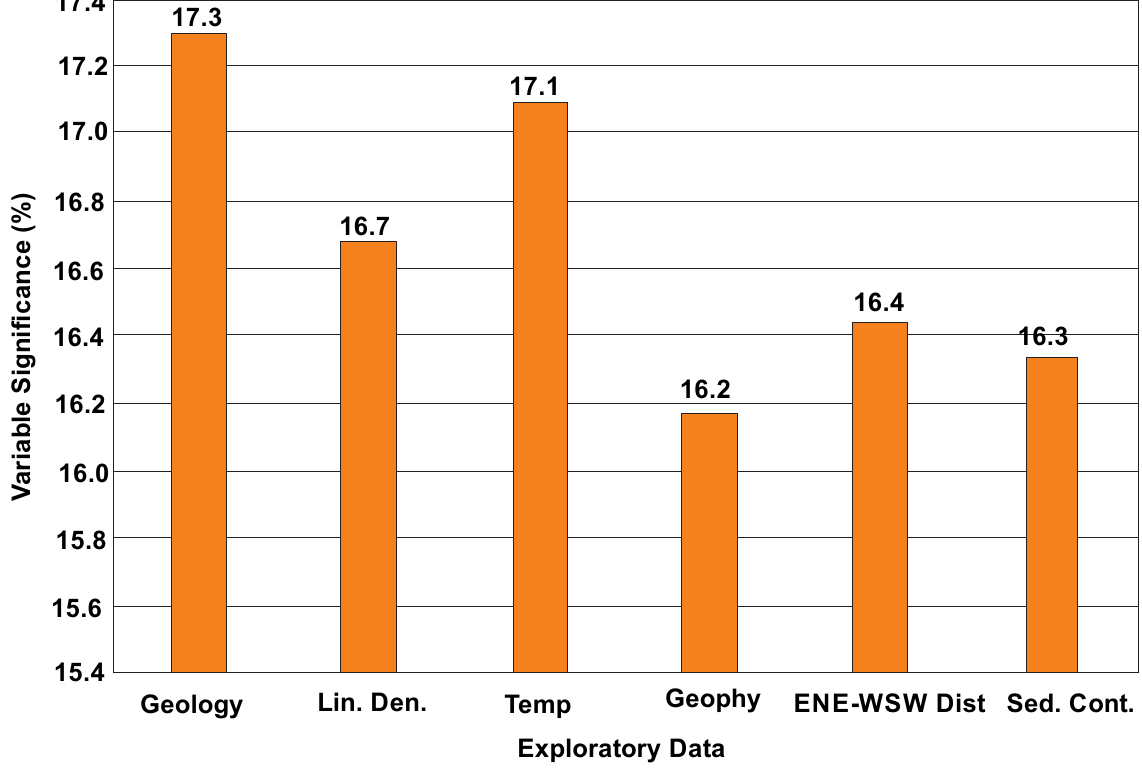
Figure 5. Variable influential analysis for exploration